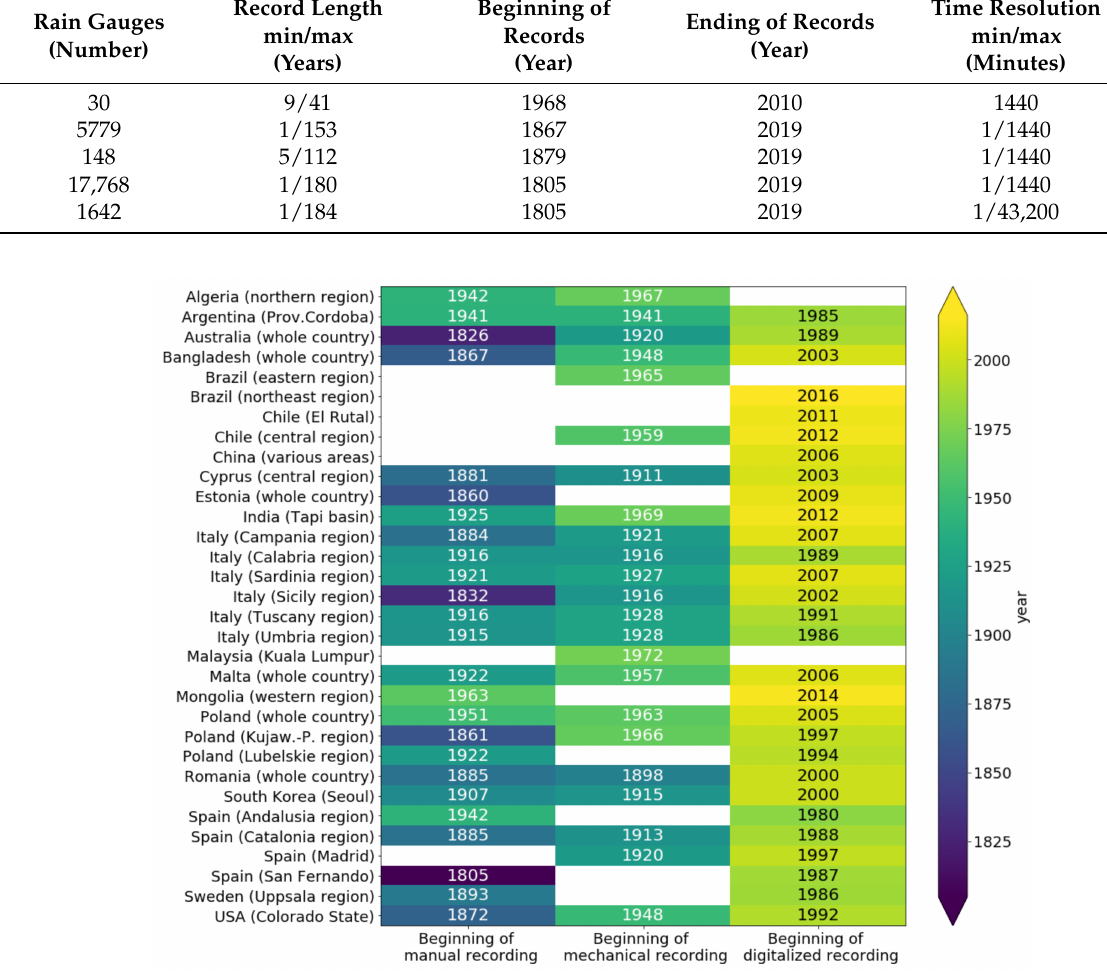
Figure 5. Year of beginning of manual, mechanical, and digital rainfall recordings for the study areas considered in